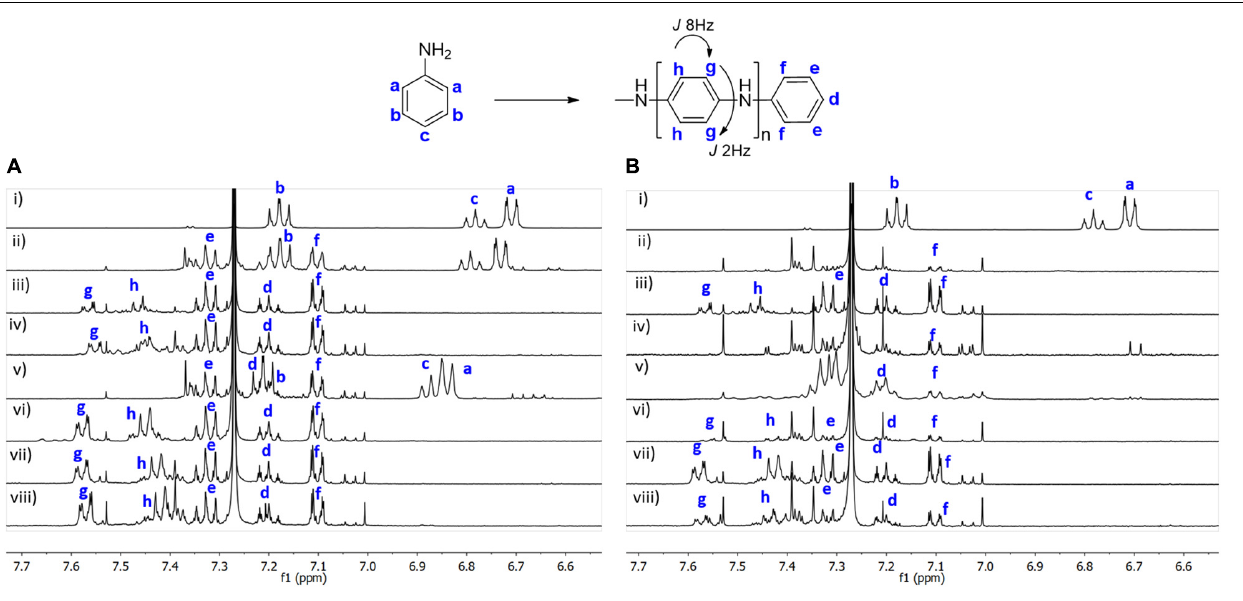
us to assume that higher amount of polymer is entrapped inside BC which, due to mobility constrains, are not released to the reaction solution, remaining inside the BC the porous support material is expected to confer greater electric conductivity.